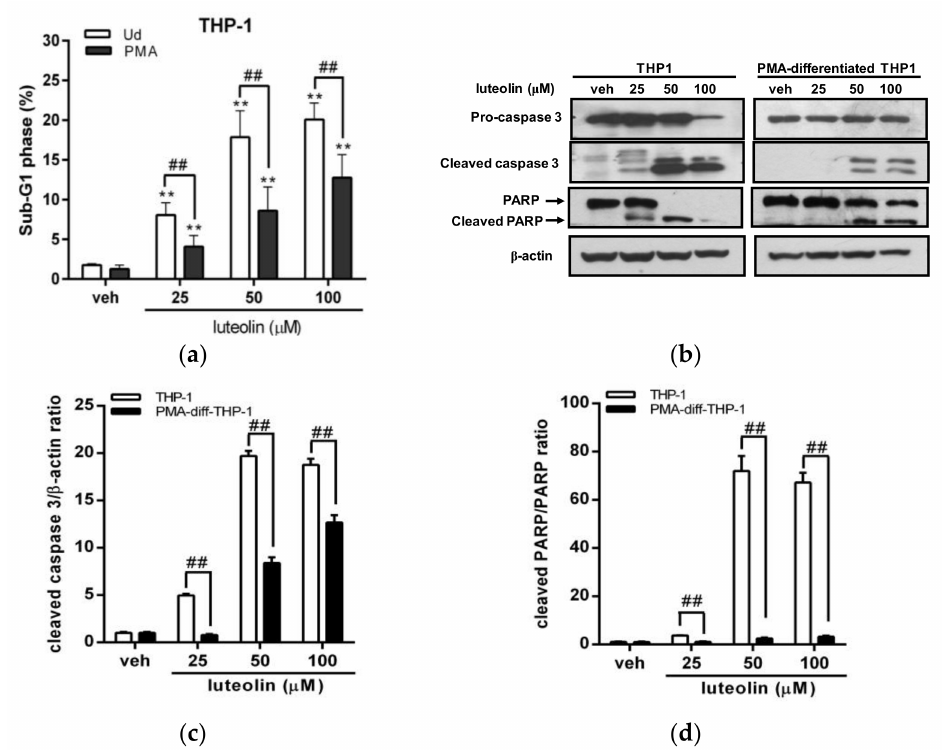
Figure 3. Effects of luteolin on the apoptosis of THP-1 cells with differential PTTG1 expression. ( a ) The undifferentiated or PMA-differentiated THP-1 cells were treated with vehicle or luteolin (25–100 µ M) for 24 h, and then, the cell population in sub-G1 phase was determined by flow cytometric analysis. The experiments were triplicated, and the data are presented as the means ± SD from three independent experiments. ** p < 0.01 represents a significant difference compared to the vehicle group (veh). ## p < 0.01 represents a significant difference compared to the undifferentiated cells (Ud group). ( b ) Apoptotic marker proteins, including pro-caspase 3, cleaved caspase 3, PARP1 and cleaved PARP1, were analyzed by Western blot analysis. The experiments were triplicated, and a representative blot is shown. ( c ) The intensity of cleaved caspase 3 versus β -actin proteins is normalized and presented as the mean ± SD of triplicated experiments. ( d ) The intensity of cleaved PARP1 versus total PARP1 proteins is normalized and presented as the mean ± SD of triplicated experiments. ## p < 0.01 represents a significant difference compared to the undifferentiated THP-1 cells (THP-1